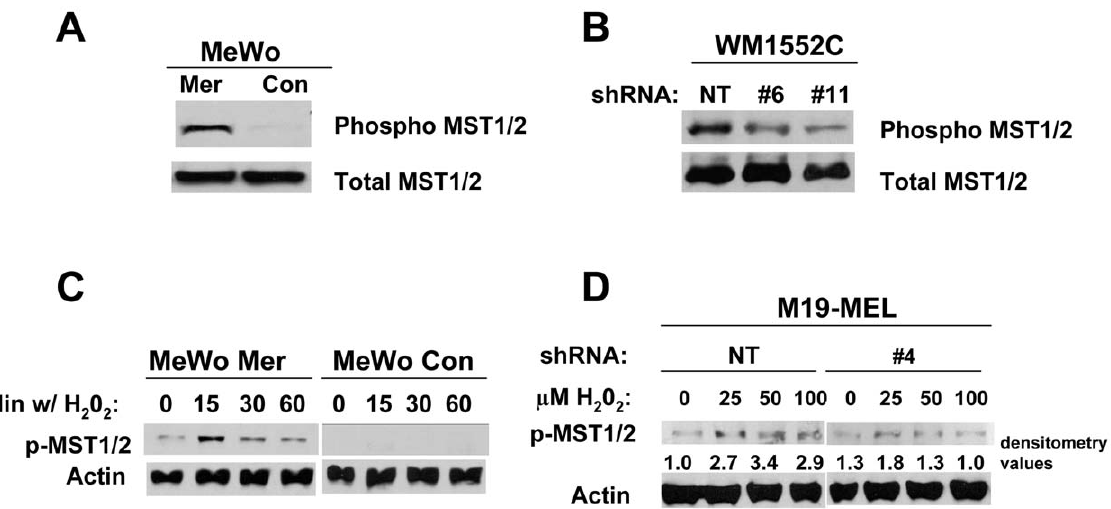
Figure 6. Increased merlin levels promote MST1/2 kinase activation whereas merlin knockdown impairs the stress-induced activation of MST1/2. A , Western blot analysis of phosphorylated MST1/2 kinases was performed in the transduced MeWo cells at 80% confluence. B , Western blot analysis of phosphorylated MST1/2 kinases in the confluent WM1552C cells with or without merlin knockdown. C , Western blot analyses of the transduced MeWo cells treated with H 2 O 2 and probed for activation of MST1/2 Ser/Thr kinases. The cells were treated with 500 m m H 2 O 2 for indicated times. D , Western blot of the cell lysates derived from transduced M19-MEL cells treated with indicated H 2 O 2 concentrations for 15 min. 50 m g of protein was loaded in each lane and actin was included as a loading control in panels C and D. Numbers are densitometry values used to normalize phosphor-MST1/2 to actin loading controls.